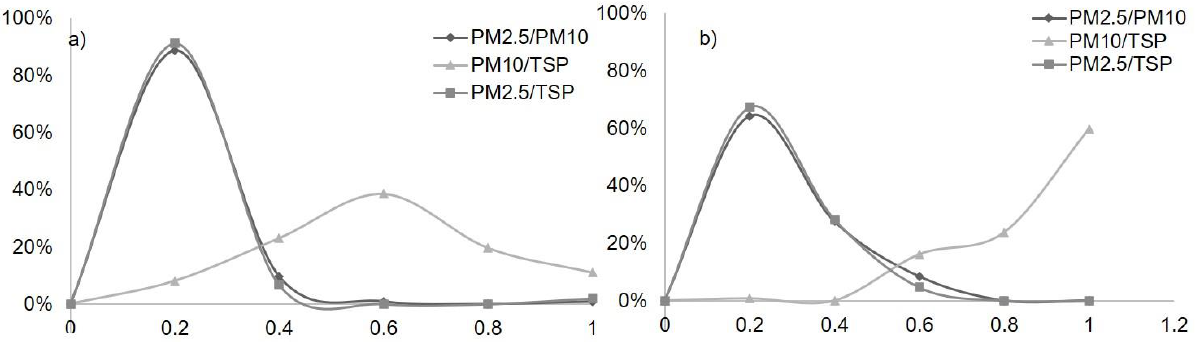
Figure 4. PM ratio for the collected emissions from Feedlot C ( a ) and Dairy B ( b ). ( x and y axis represents ratio and % data fallen in that ratio, respectively).